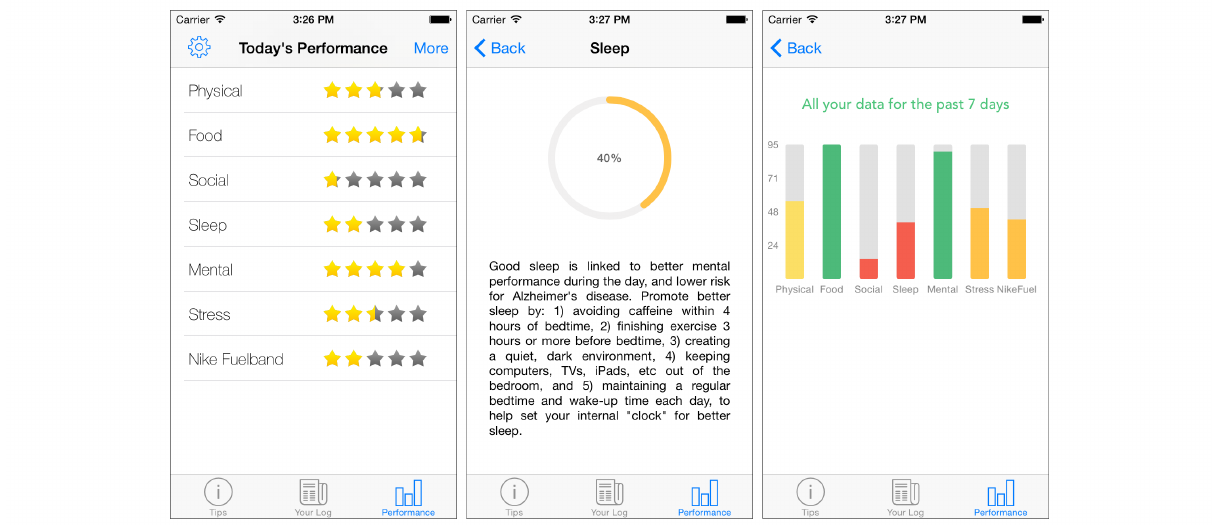
Figure 4. Performance tab showing star ratings for each domain, calculated by assessing a user’s reported values against recommended values (left). Expanded view of performance with a domain, containing additional information and helpful tips (center). A bar chart showing aggregated performance, as a percentage, from the previous week’s data (right).